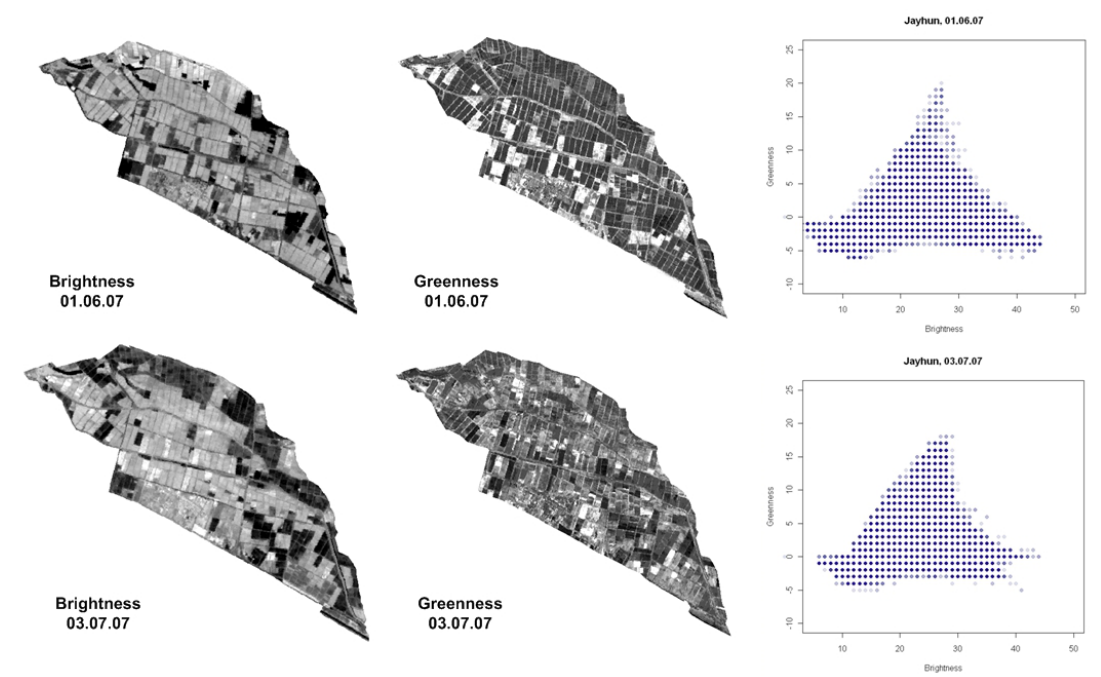
Figure 5. Tasseled cap brightness and greenness indices for the WUA ‘Jayhun’. Top: June data, Bottom: July data; The scatter plots at the right show brightness (x-axis) and greenness (y-axis) for the respective ASTER data